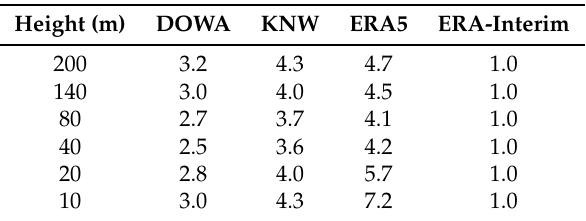
Table A1. ˆ τ D values for the different models and heights, for the full period of 10 year. Note that ˆ τ D for ERA-Interim is 1.0 (i.e., uncorrelated data) because its output is only 6-h. Taking only data every 6-h from DOWA, KNW or ERA5 would also result in ˆ τ D =